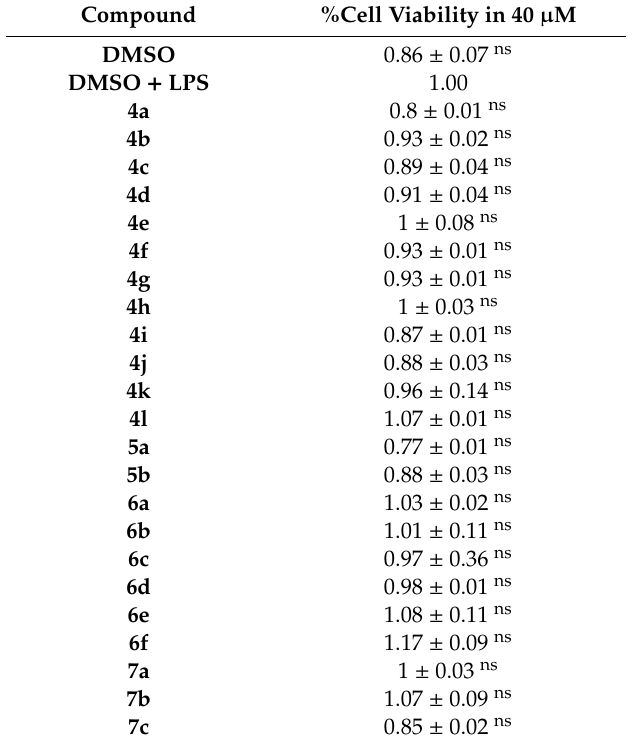
Table 2. Cell viability of RAW 264.7 cells at a compound concentration of 40 µ M.